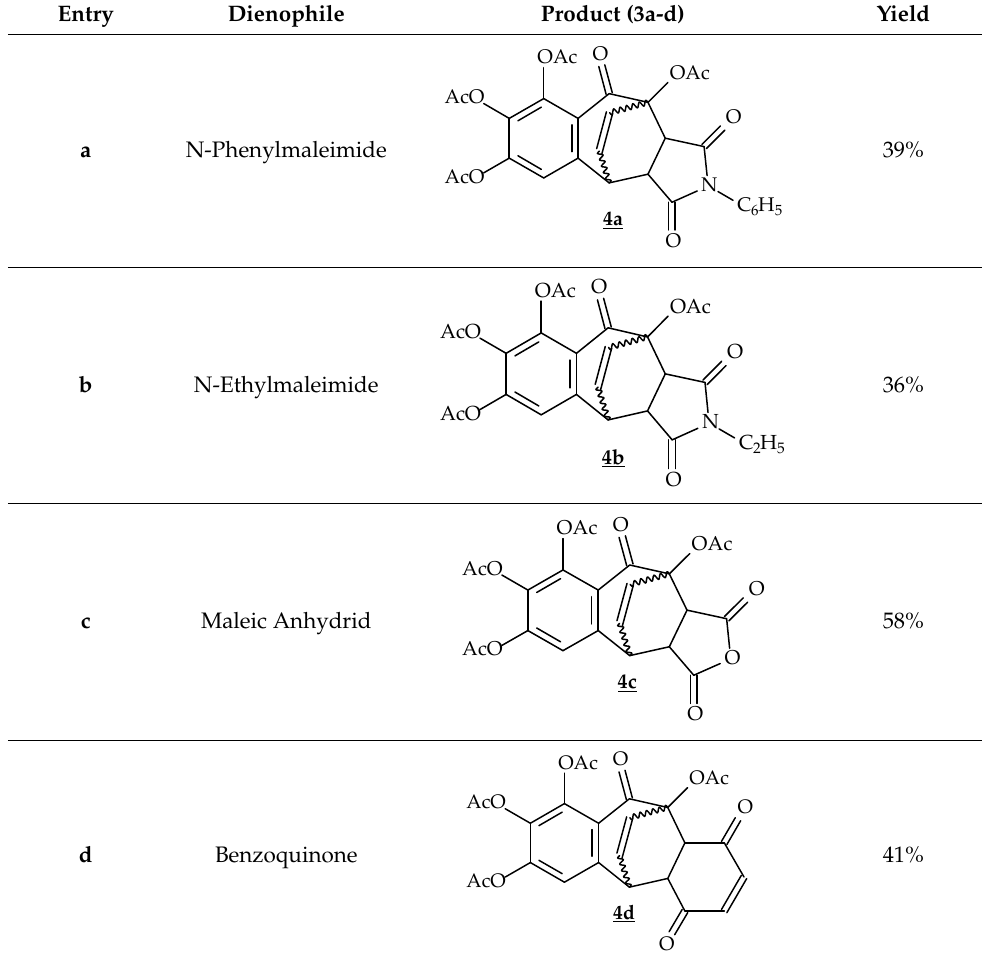
Table 1. Products of Diels–Alder reaction isolated.